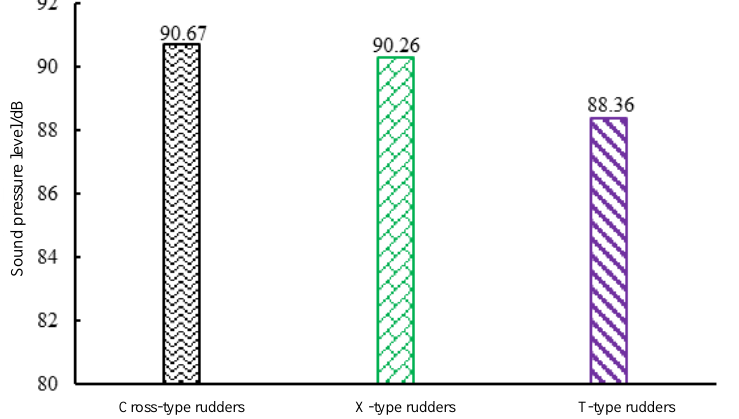
Figure 19. Simulation results of total sound pressure level of the underwater vehicle with full ap- pendages.